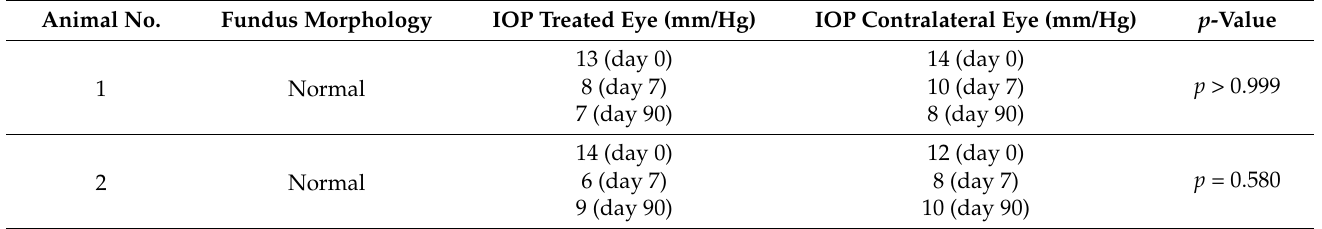
Table 2. Fundus and IOP of treated rabbits. The fundus of treated rabbits was examined in both eyes and found to be normal in all rabbits at all time points. IOP was measured pre- and post-treatment in the treated and contralateral eye; a small decrease in IOP was noted during the first week that recovered without further intervention. Comparison between both eyes in animal 1 and in animal 2 revealed no statistical differences (paired t